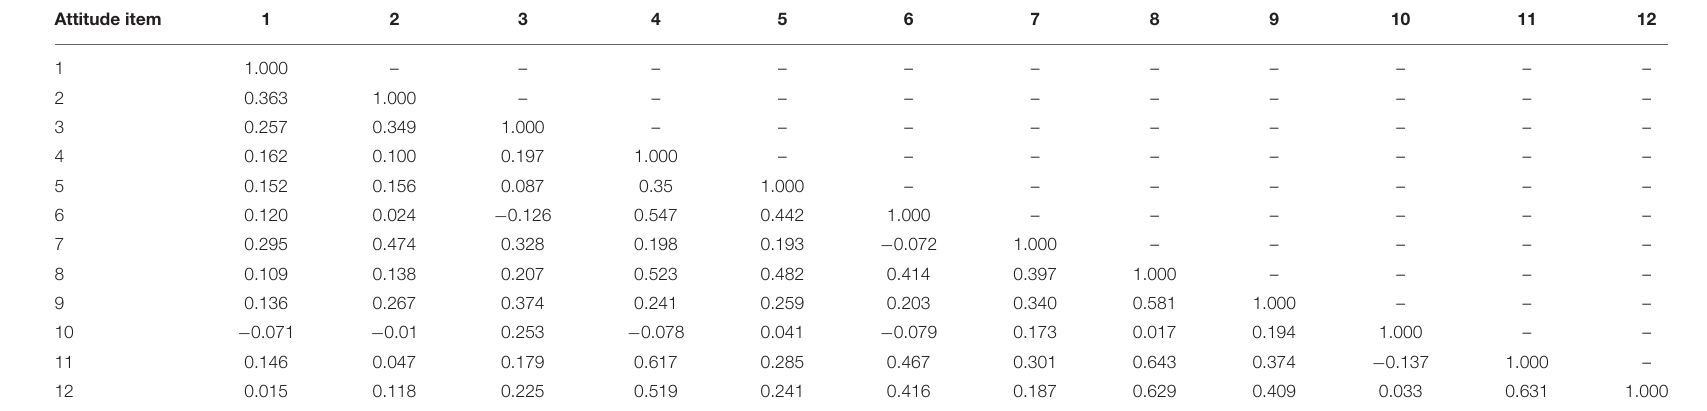
TABLE 6 | Inter-item correlation coefficients for Indonesian adolescents’ attitude toward mental health questionnaire. Attitude